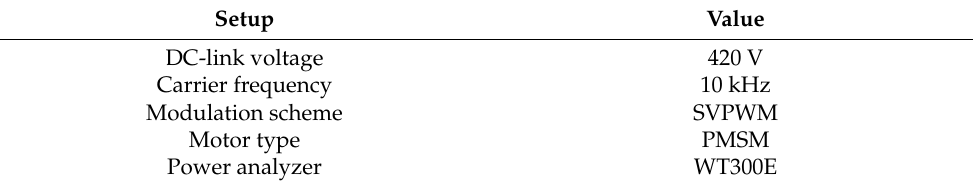
Figure 2. Drivetrain test bench for motor and inverter. Table 1. Configuration for the Drivetrain Efficiency Testing and Simulation.